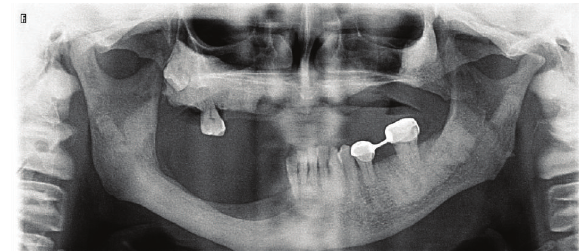
Figure 1: Panoramic radiography of the patient before extraction of the left maxillary central and lateral incisor in 2011.